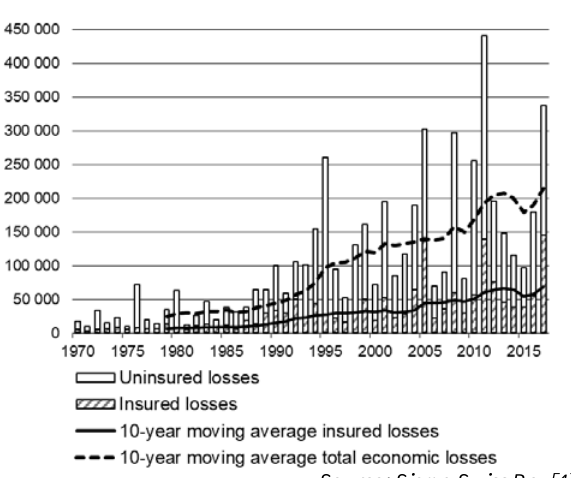
Fig. 2. Insured vs uninsured losses, 1970 – 2017, in USD billion at 2017